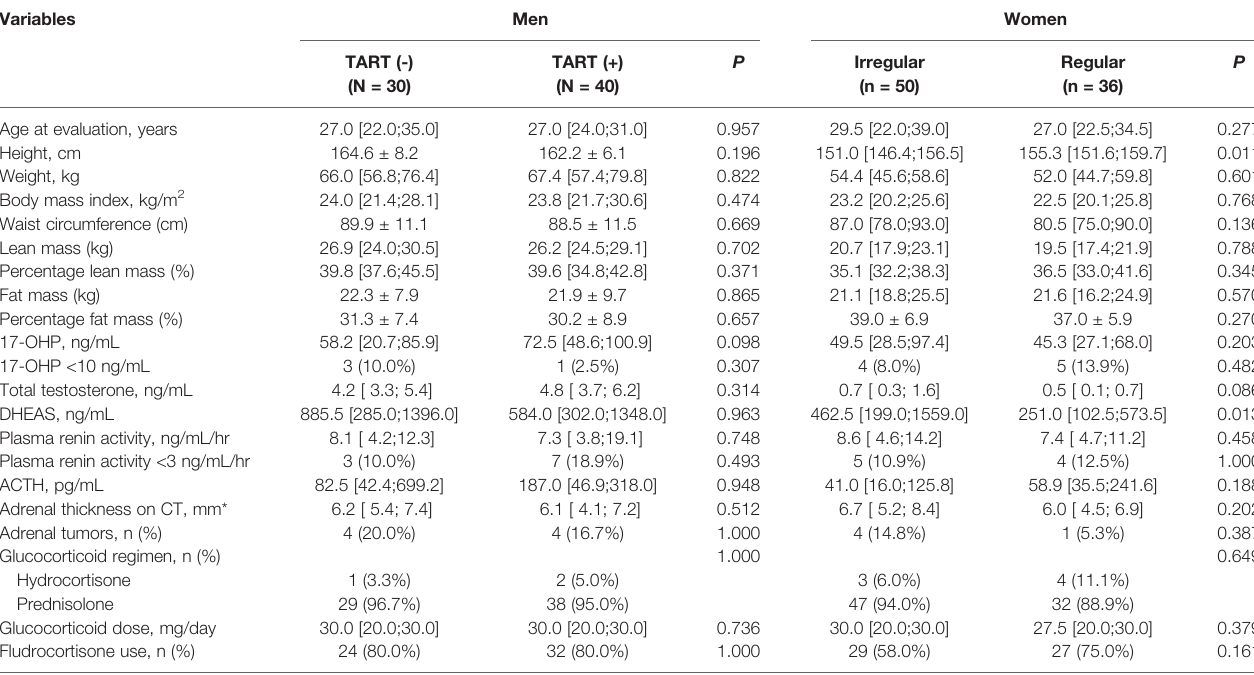
TABLE 4 | Hormone status and treatment regimen in men with CAH according to the presence of testicular adrenal rest tumors (n = 70) and women with CAH according to menstruation (n = 86). Variables Men Women TART (-) TART (+) P Irregular Regular P (N = 30) (N = 40) (n = 50) (n = 36) Age at evaluation,